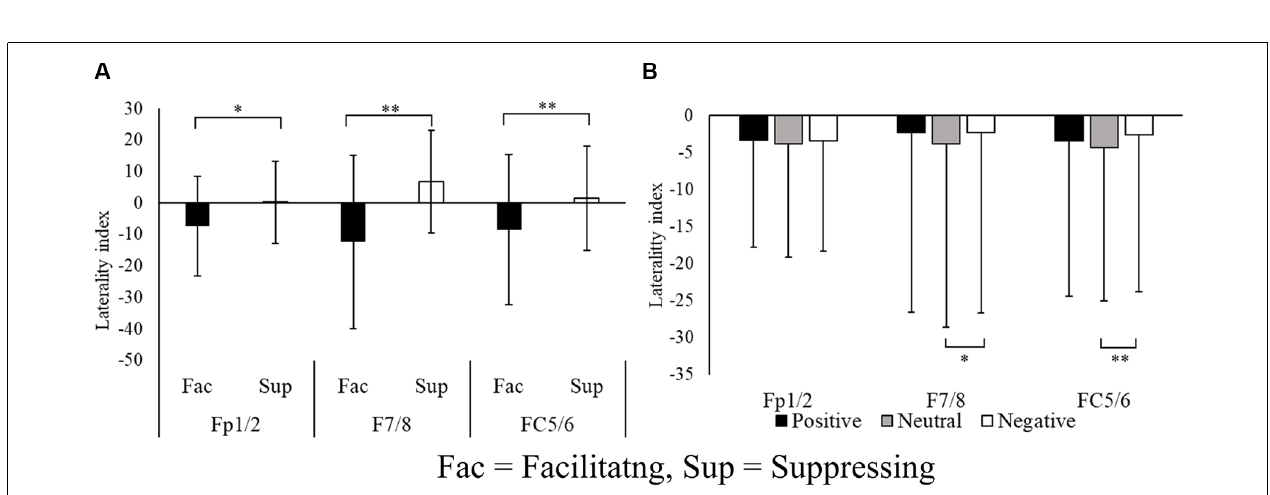
FIGURE 3 | Mean electromyography (EMG) amplitude for CS (A) and ZM activity (B) in each condition. ∗ p < 0.05, ∗∗ p < 0.01 and ∗∗∗ p < 0.001.